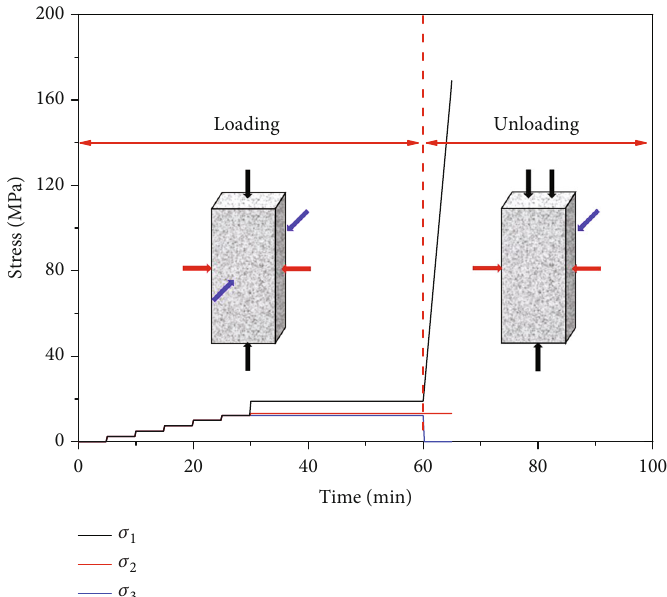
Figure 3: Loading path of granite rock burst